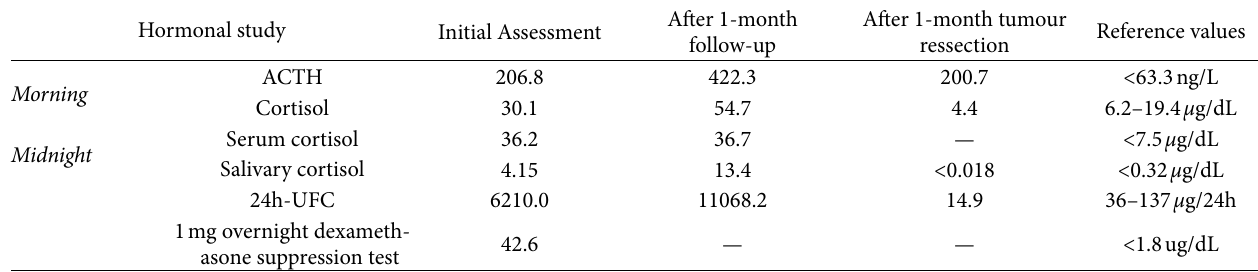
Table 1: Hormonal profile.